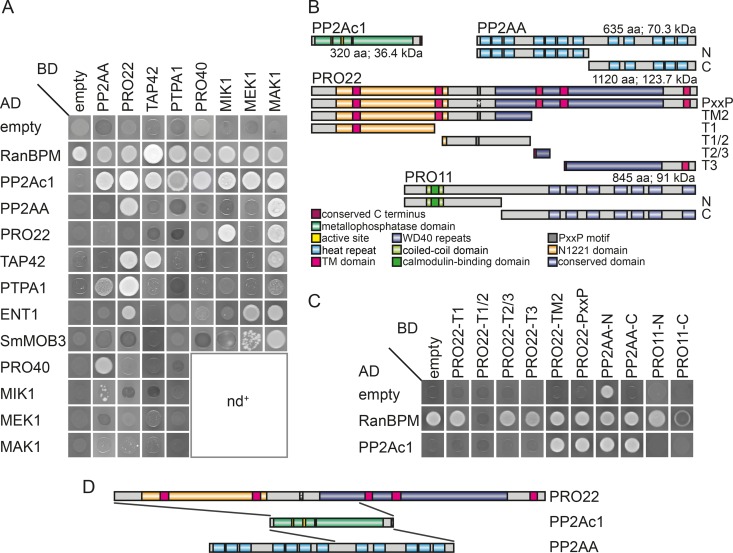
Interaction of STRIPAK components and CWI pathway module subunits. (A) Interaction of fusion proteins was tested in a Y2H analysis by measuring the growth of diploid strains on synthetic defined (SD) medium lacking adenine, histidine, leucine, and tryptophan. The corresponding growth control is shown in Fig. S4A in the supplemental material. nd+, not determined in this study. (B) Protein domain structure of PP2Ac1, PP2AA, PRO22, and PRO11. The fragments used for interaction site analysis are depicted below the full-length proteins. TM, transmembrane; aa, amino acids. (C) Interaction of PRO22, PP2AA, and PRO11 subfragments with PP2Ac1 was tested on SD medium lacking adenine, histidine, leucine, and tryptophan/uracil, and the corresponding growth control is shown in Fig. S4B in the supplemental material. (D) Schematic illustration of interaction sites of PP2Ac1 and PRO22 and of PP2Ac1 and PP2AA. Gray lines indicate the interaction sites determined in panel C.